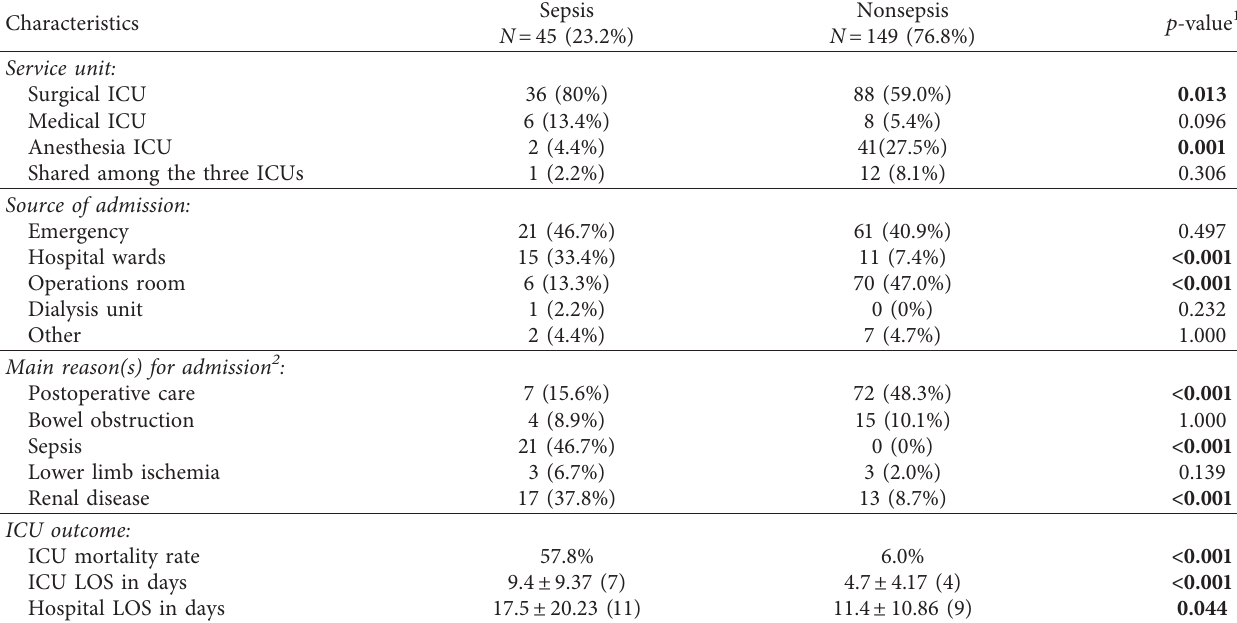
Table 4: Characteristics related to ICU admission and stay in sepsis and nonsepsis